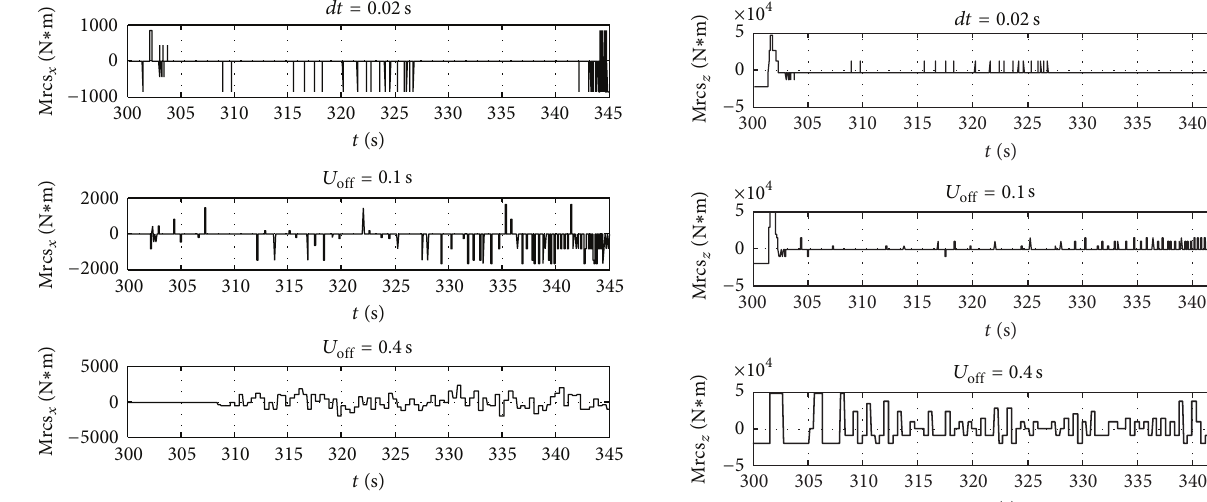
Figure 35: Simulation result of RCS roll moment.